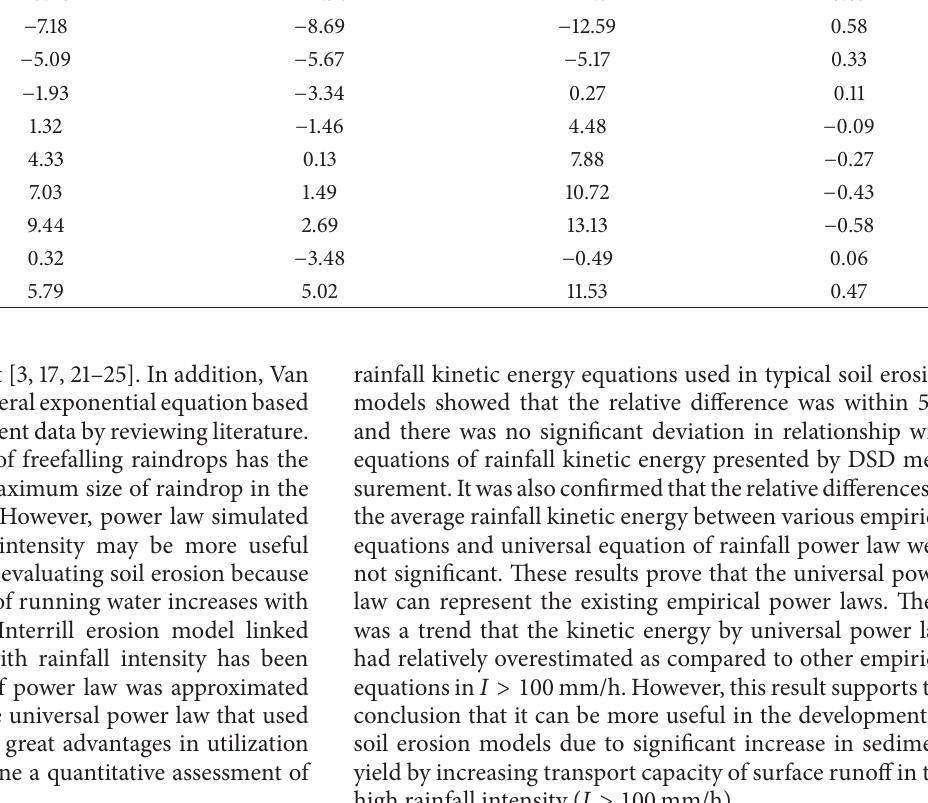
Relative difference with Relative difference with Relative difference Relative difference exponential function logarithmic function with linear function with power law (%) (%) (%) (%) −